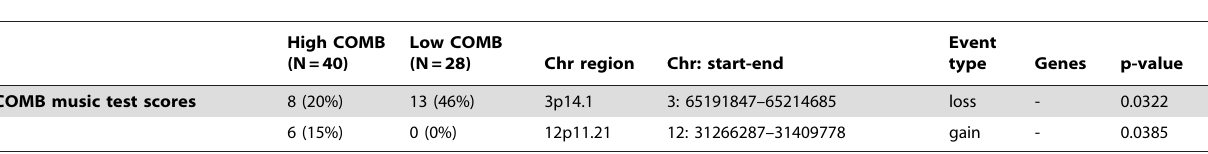
Table 4. Association of CNVRs with music test scores in the unrelated dataset.